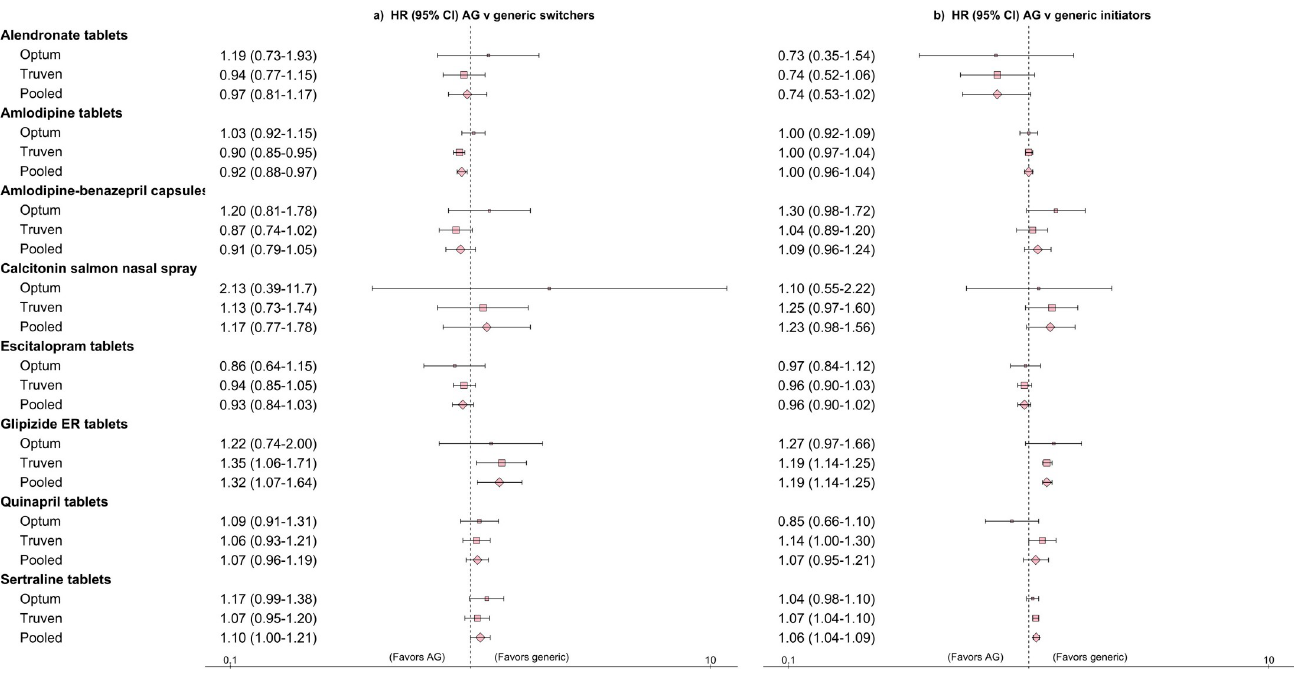
Fig 2. Hazard ratios (HRs) and 95% confidence intervals (CIs) comparing outcomes for patients initiating authorized generics (AGs) versus generics, and patients switching from brand-name products to AGs versus generics, after 1:1 propensity score matching in each database. The outcome for amlodipine tablets, amlodipine-benazepril capsules, and quinapril tablets was a composite endpoint comprising hospitalization for myocardial infarction, ischemic stroke, or coronary revascularization procedures. The outcome for alendronate tablets and calcitonin salmon nasal spray was a composite non-vertebral fracture endpoint comprising humerus, wrist, hip, or pelvis fractures. The outcome for escitalopram tablets and sertraline tablets was hospitalization with a psychiatric condition as the principal discharge diagnosis code. The outcome for glipizide extended release (ER) tablets was initiation of insulin during the follow-up period.